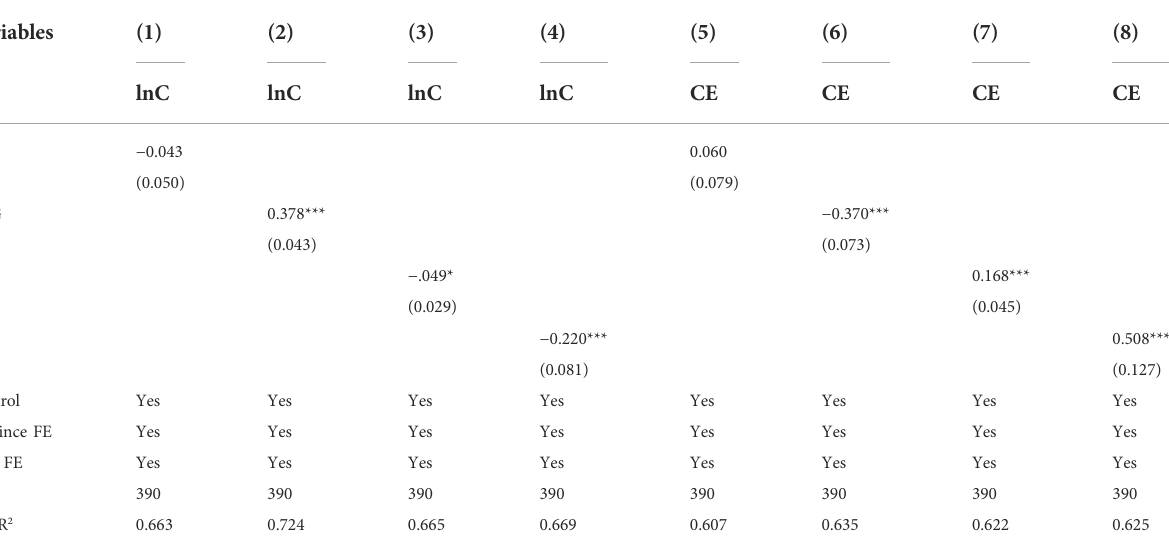
TABLE 5 Sub-dimensional regression